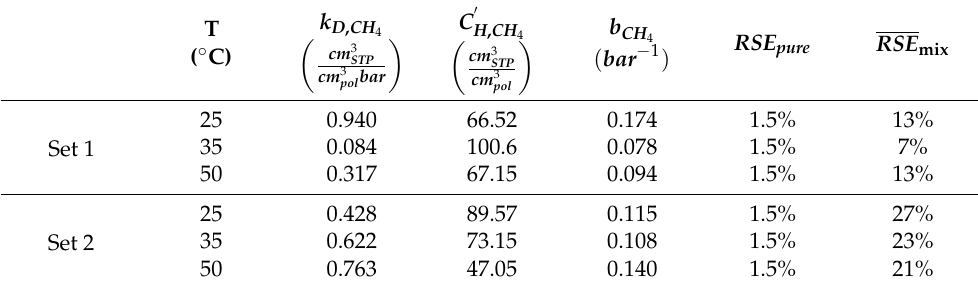
Table 3. DMS model fugacity-based parameter sets used to calculate mixed-gas sorption of CO 2 and CH 4 in PIM-1 reported in Figure